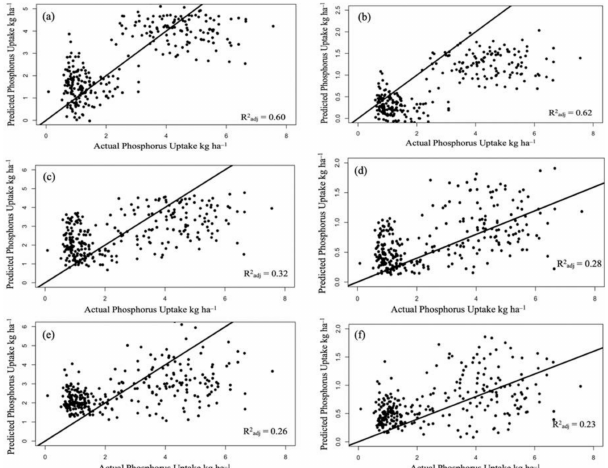
Figure 5. Relationship between actual and predicted phosphorus for ( a ) 9 July, the untransformed model; ( b ) 9 July, the transformed model; ( c ) 12 July, the untransformed model; ( d ) 12 July, the transformed model; ( e ) 18 July, the untransformed model; ( f ) 18 July, the transformed